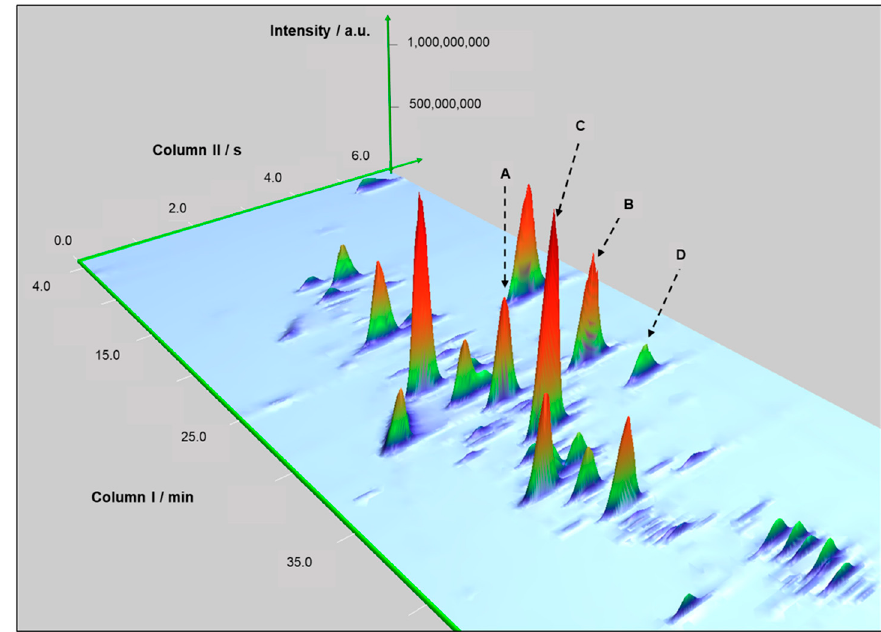
Figure 3. Example of resolved peaks in the second dimension of the chromatograms for BR. Second dimension resolved trans-geraniol (peak A) and 2-phenylethyl acetate (peak B). Additionally, (E)-methyl geranate (peak C) and 4-vinylguaiacol (peak D).